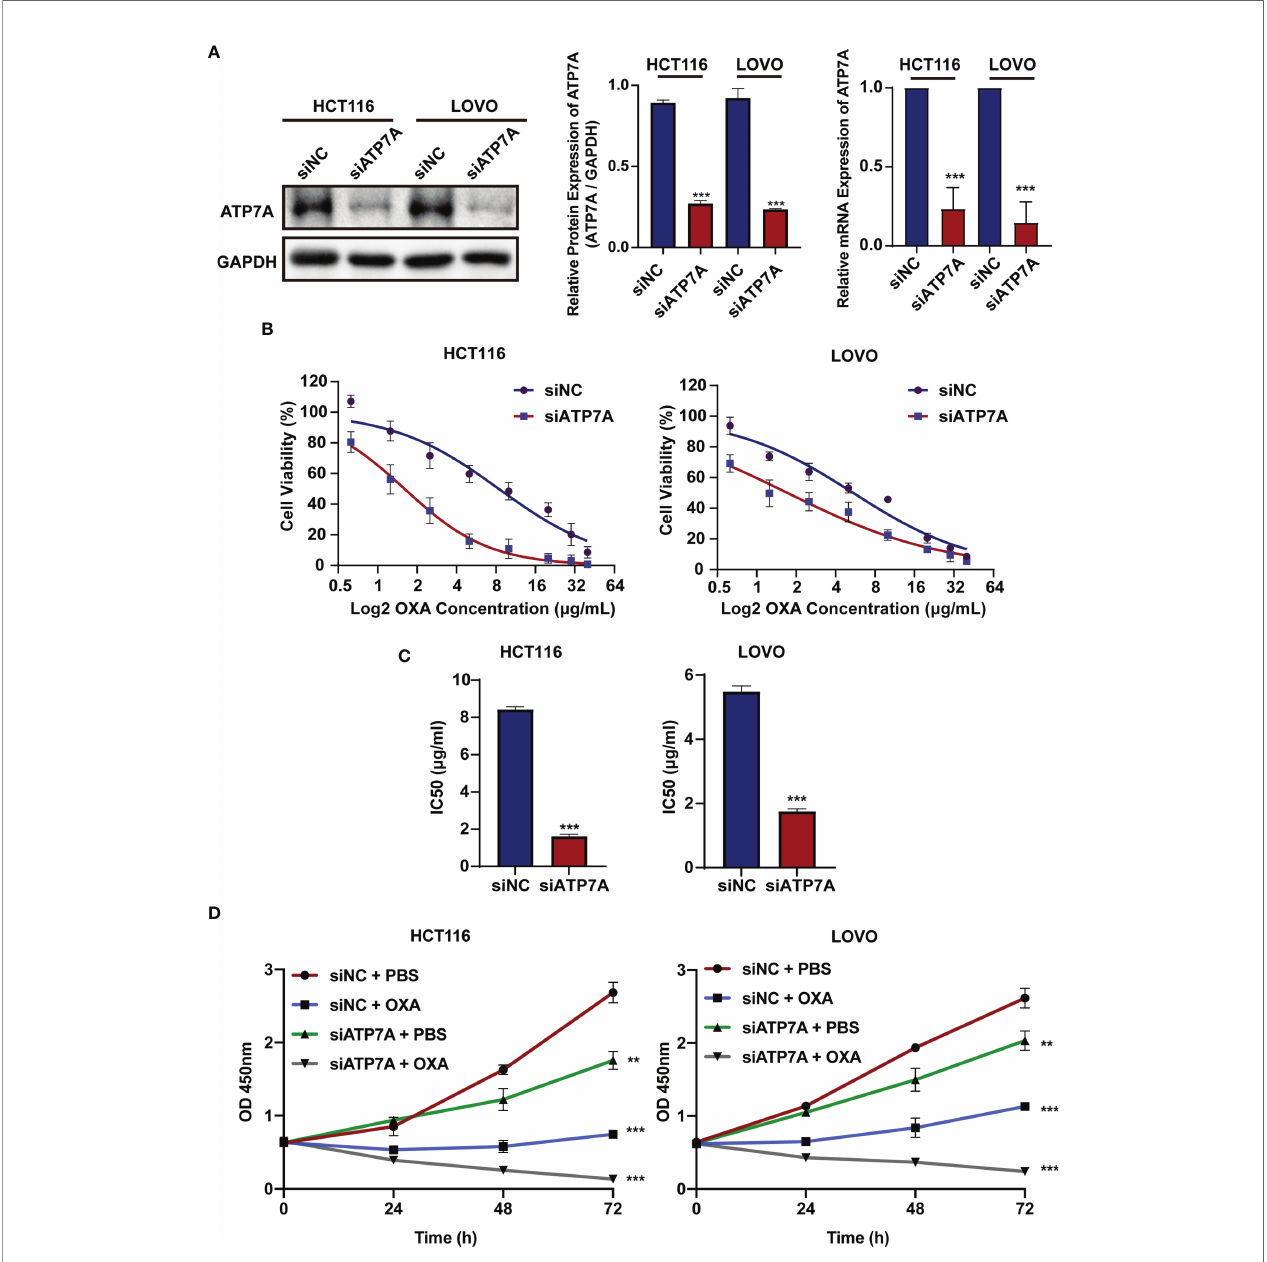
FIGURE 2 | ATP7A inhibition reverse OXA resistance in vitro . (A) ATP7A protein and ATP7A mRNA expression were inhibited by the siATP7A in HCT116 and LOVO cell lines. (B) OXA sensitivity in HCT116 and LOVO cell lines treated with siATP7A was determined using the CCK-8 test after treatment with various concentrations of OXA for 48 h. (C) The IC50 of OXA for siNC and siRNA transfected HCT116 or LOVO cells. (D) Together with OXA, decreased expression of ATP7A signi fi cantly suppressed cancer cell lines proliferation. **P < 0.01 and ***P < 0.001 when compared to the control